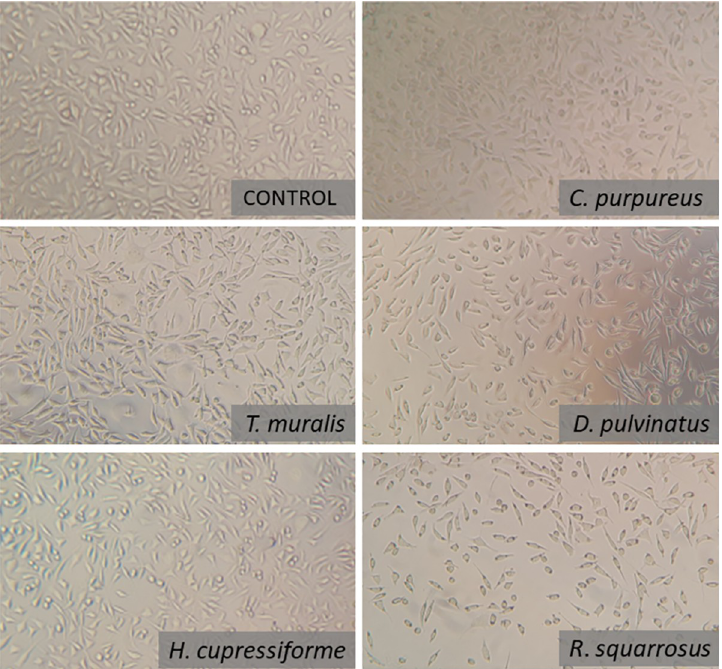
Fig 6. The effect of moss extracts used at the concentration 250 μ g/mL on L929 cell monolayer. The images were taken by inverted light microscopy after 24 h exposure of the cells to the extracts.